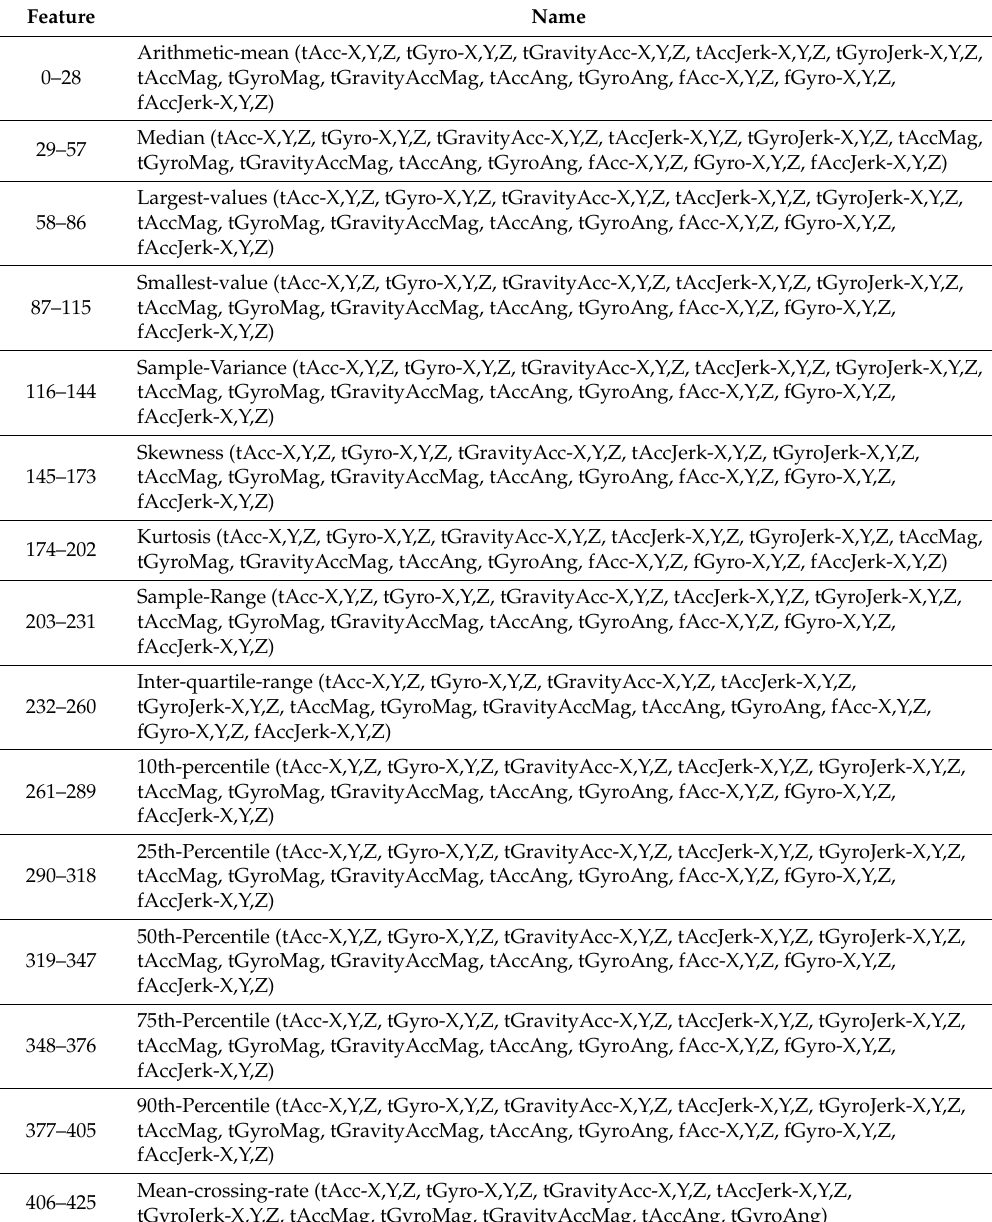
Table 4. Features derived from raw sensor